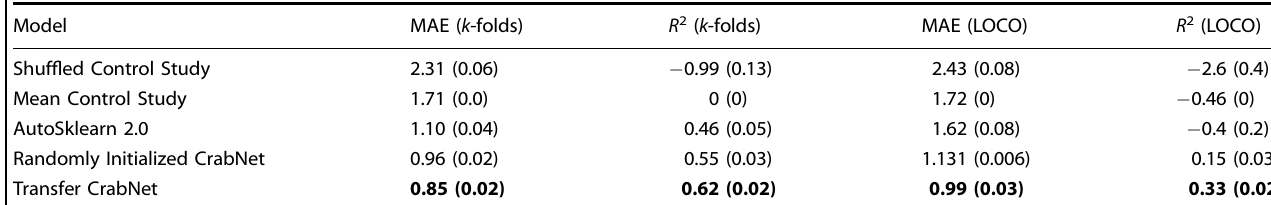
Table 3. Regression Performance Metrics Average results of each regression model, judged by Mean Absolute Error and Pearsons R 2 metric under both dataset cross-validation regimes.